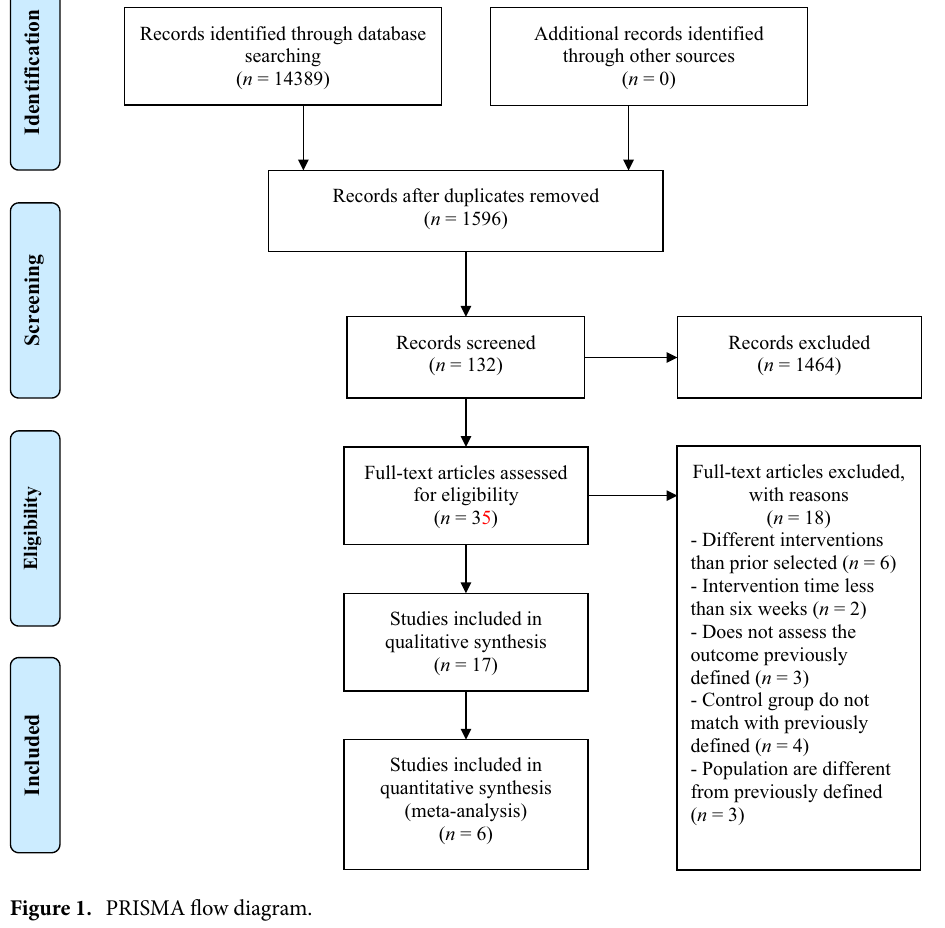
Figure 1. PRISMA flow diagram.